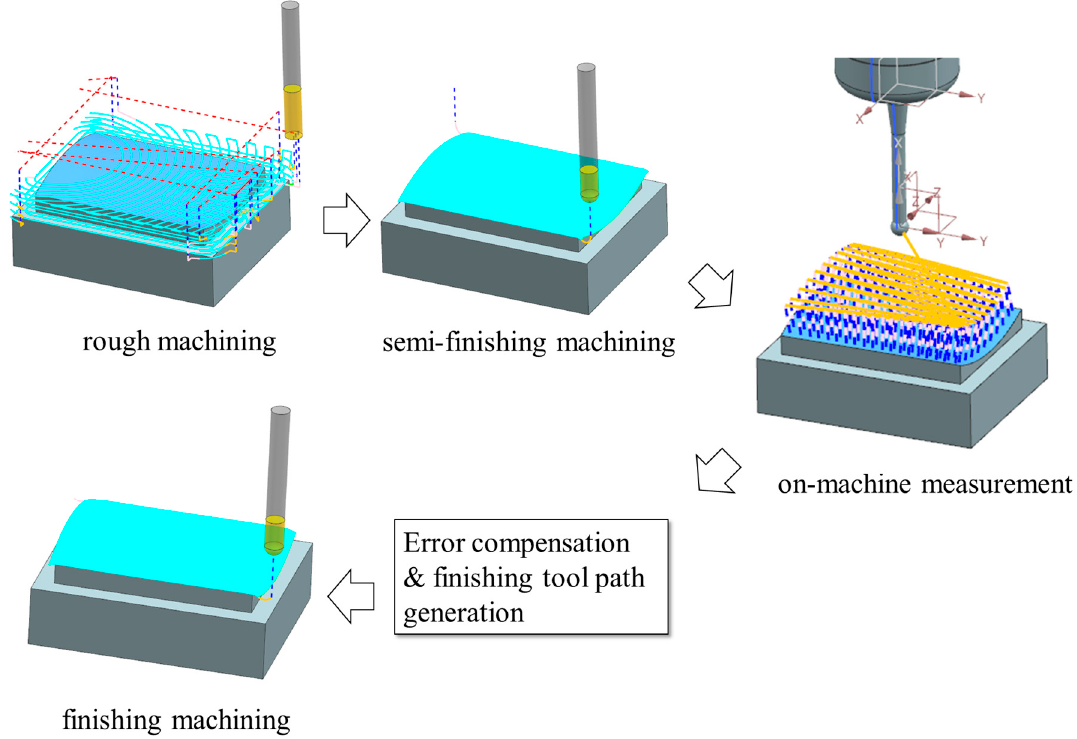
Figure 9. Complete machining processes with error